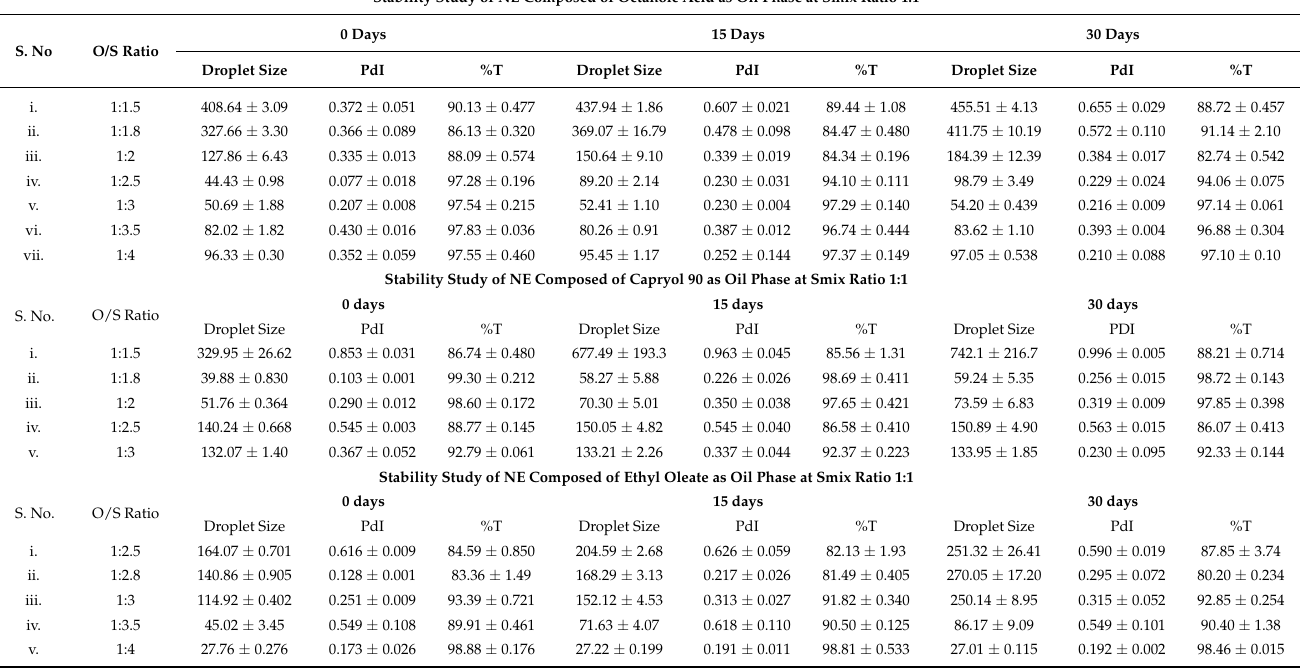
Table 4. Stability study of OA, C90, and EO-based NE system.